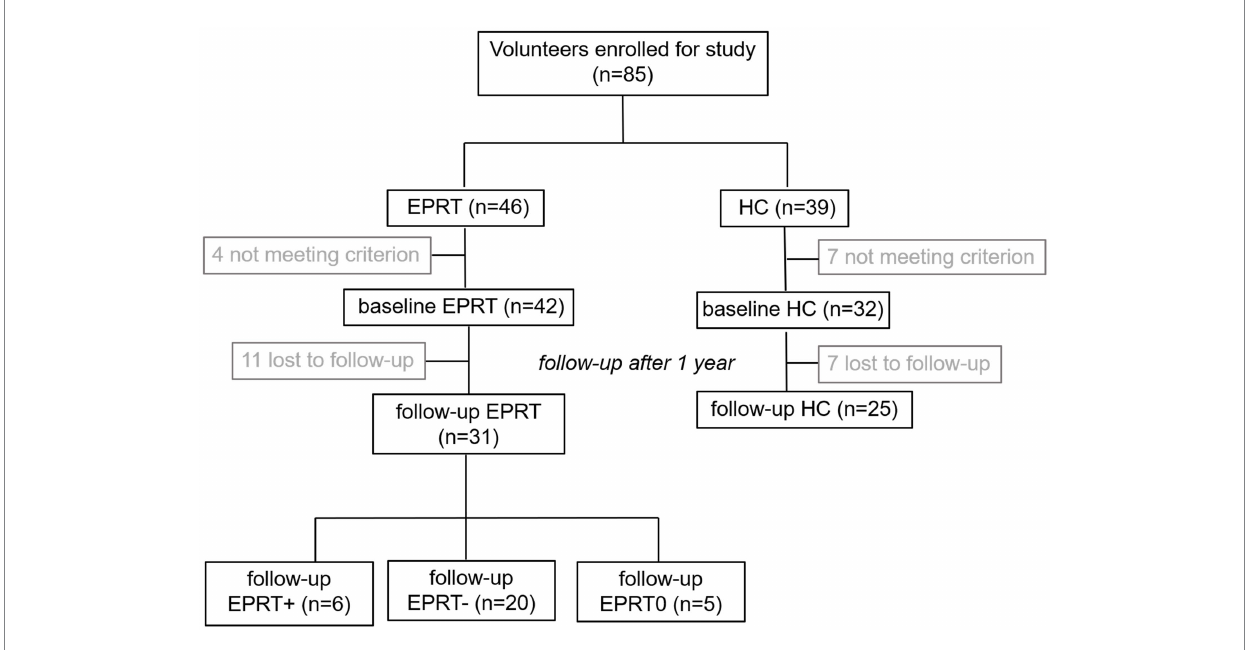
FIGURE 1 Participant flow through the